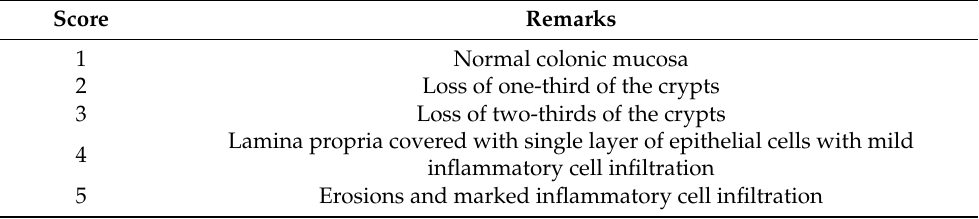
Table 2. Criteria for assessment of microscopic rectal